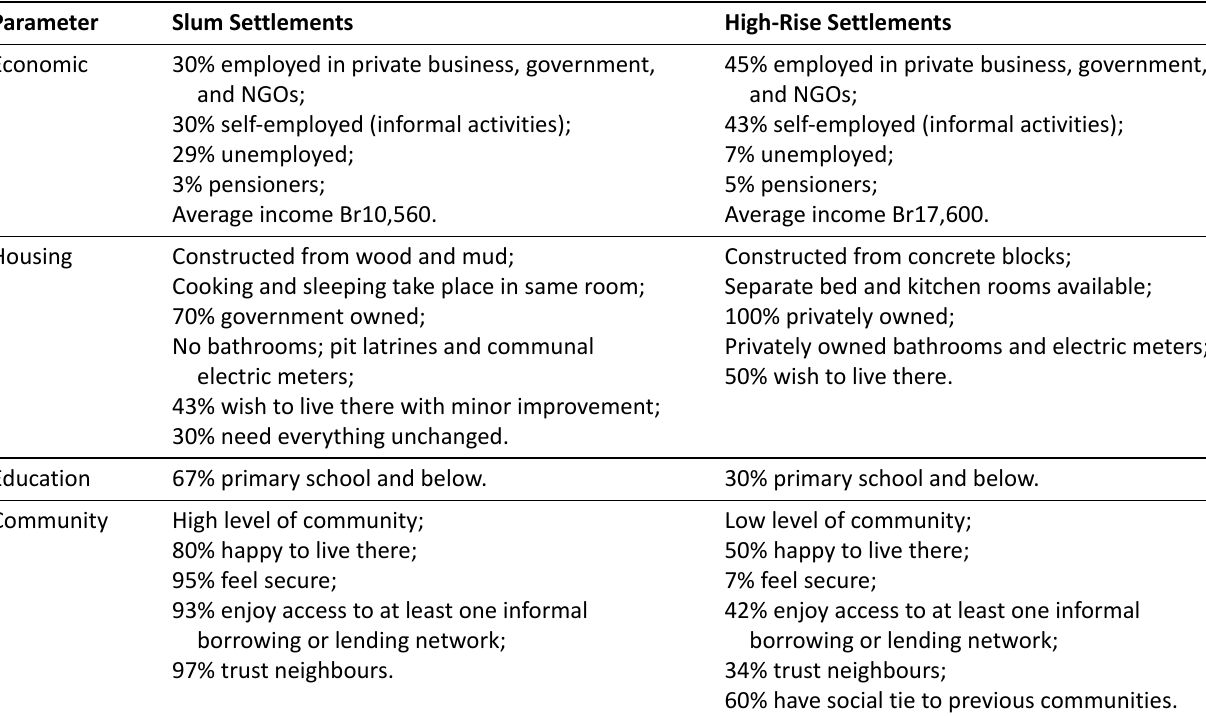
Table 6. Liveability of Arat Kilo slum settlement and high-rise settlement, Addis Ababa, Ethiopia. Source: Authors’ filed